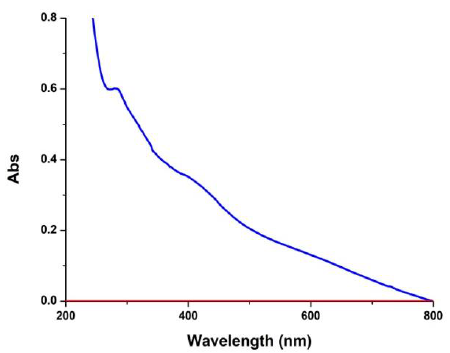
Figure 1. Ultraviolet–visible (UV–vis) absorption spectra of quartz substrates subjected to dip-coating